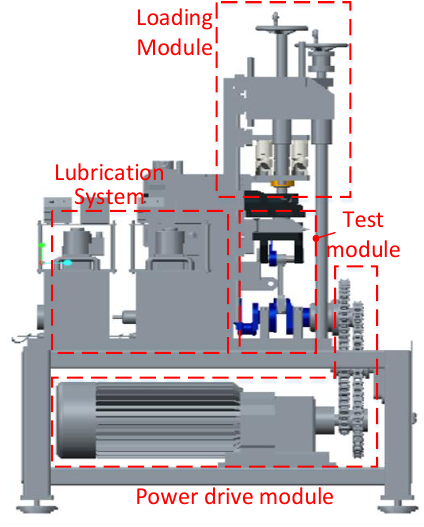
Figure 1. Structure of the test rig.